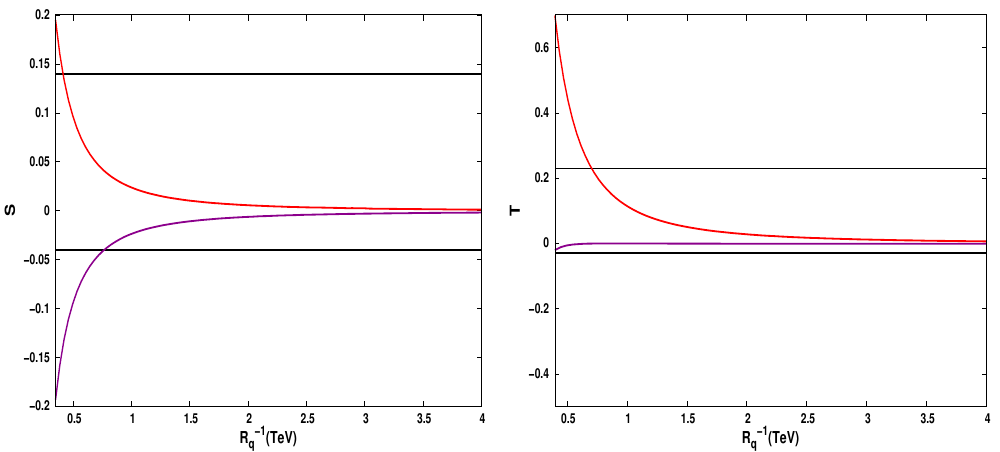
Figure 5 . S vs R (cid:0) 1 and T vs. R (cid:0) 1 obtained using c 1 ; 2 = 1(red) and c 1 ; 2 = (cid:0) 1(blue). The q q horizontal bands correspond to the 95% C.L experimental